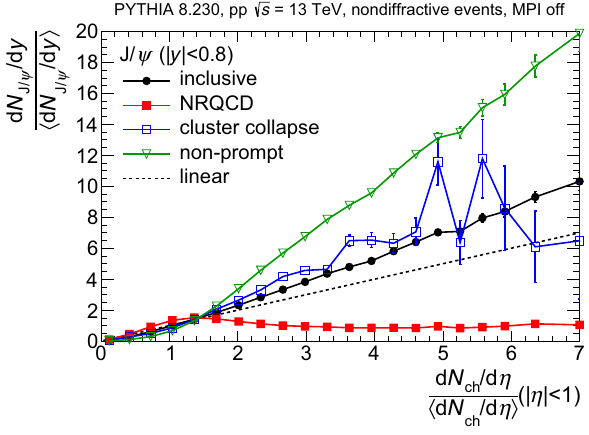
Fig. 8 Mid-rapidity J /ψ production as a function of mid-rapidity mul- tiplicity in events without MPI from